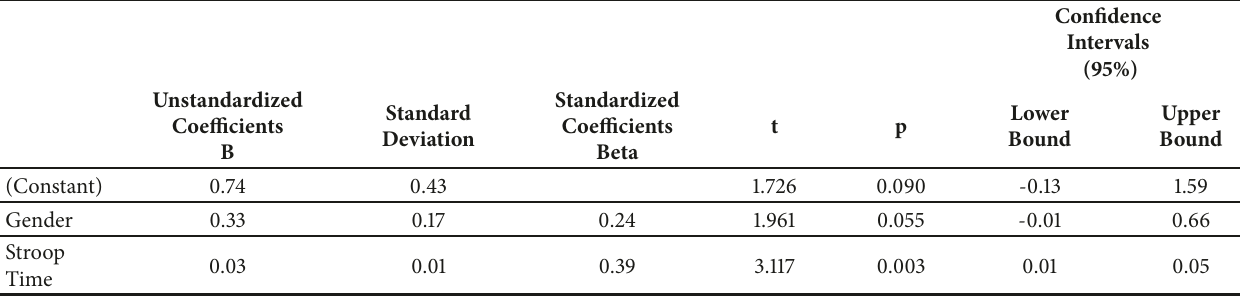
Table 5: Coefficients of best fitting MLR LRJT Right Hand Reaction Time.